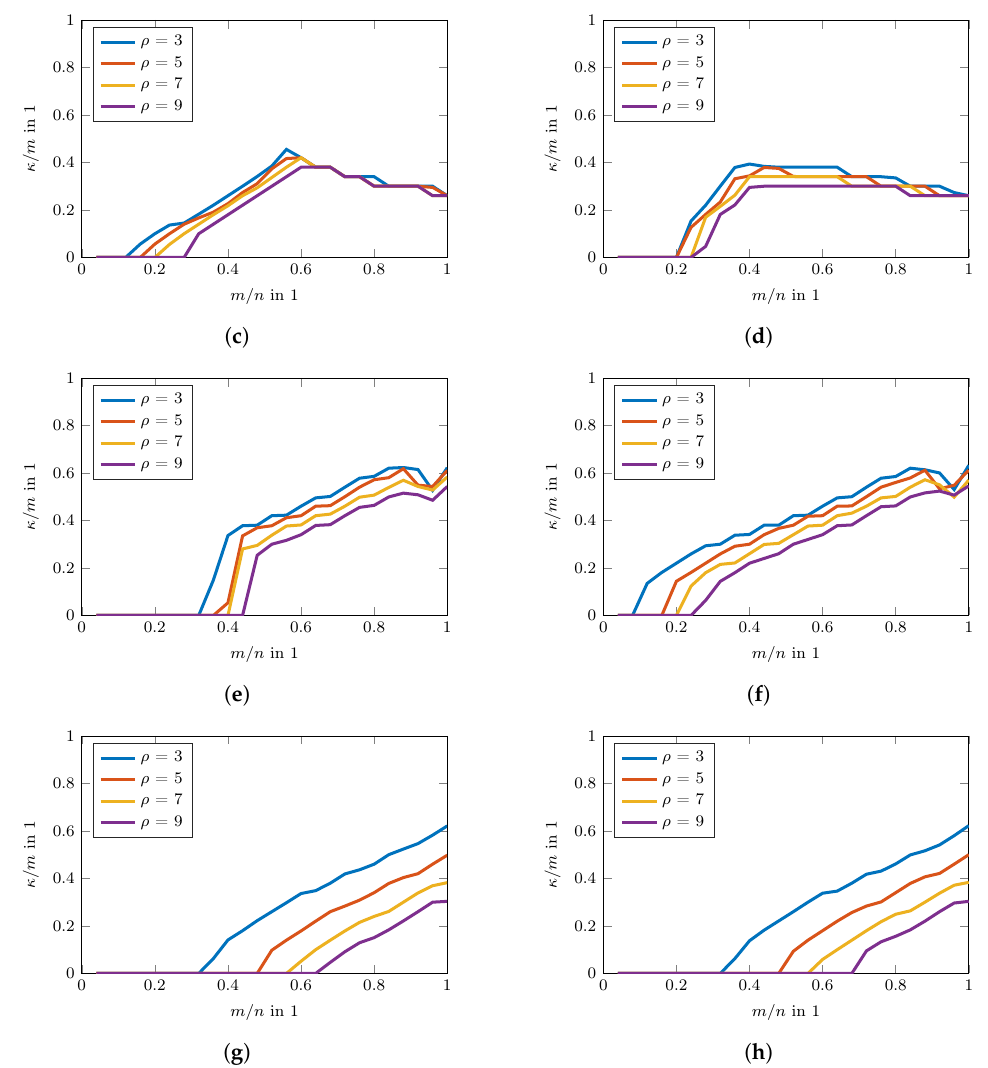
Figure 16. Comparison of reconstruction performance. Dashed lines illustrate results of Part 1 of the TCRPCA algorithm given by Algorithm 5 and solid lines the refined results achieved by Part 2 the TCRPCA algorithm given by Algorithm 6. ( a ) TCRPCA for noiselet operator. ( b ) TCRPCA for DFT operator. ( c ) TMP-CRPCA for noiselet operator with K = κ and R = ρ . ( d ) TMP-CRPCA for DFT operator with K = κ and R = ρ . ( e ) NFL for noiselet operator with K = κ and R = ρ . ( f ) NFL for DFT operator with K = κ and R = ρ . ( g ) SpaRCS for noiselet operator with K = κ and R = ρ . ( h )